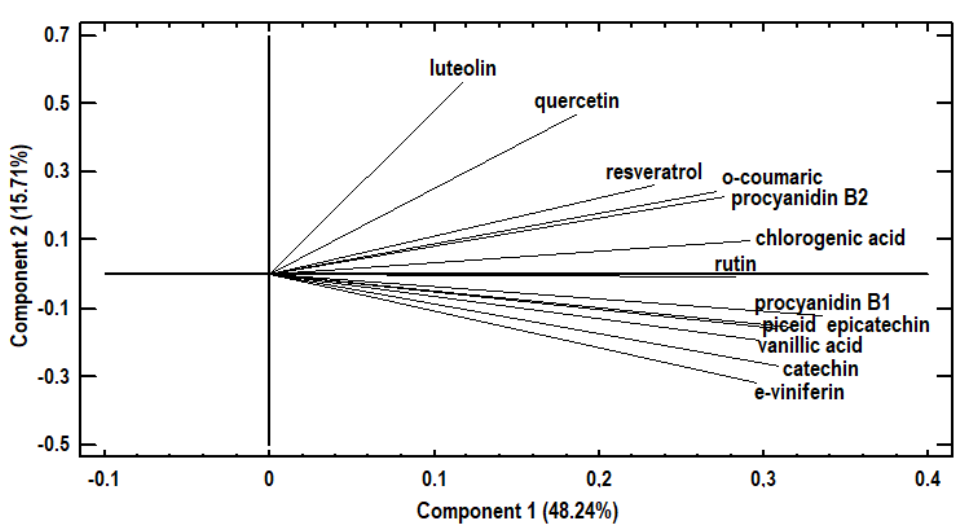
Figure 2. Principal Component Analysis: plot of the polyphenols in relation to the first two principal components (PC1 &